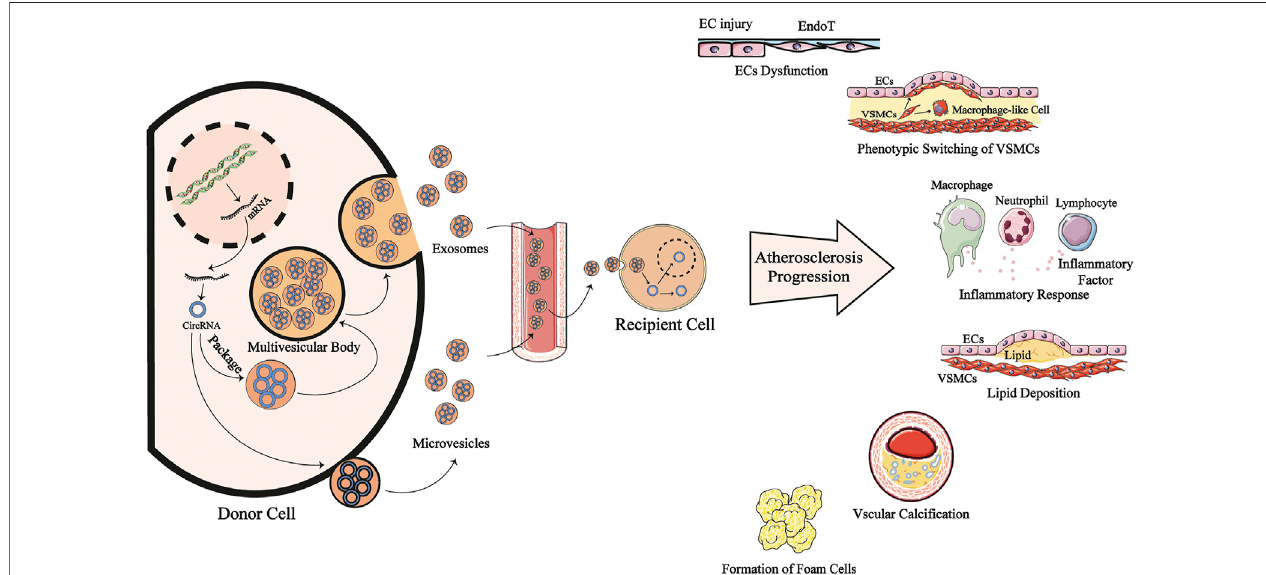
FIGURE2| EV-transmittedcircRNAsareinvolvedintheprogressionofAS.CircRNAsareproducedbyback-splicingfrommRNAandputintoextracellularvesicles mainly exosomes and microvesicles, becoming EV-circRNAs. This process may be interfered by risk factors of antheroslerosis. After entering systemic circulation, theses EV-circRNAs are transported to recipient cells and regulating cells function in cytoplasm or nucleus. They may modulate the dysfunction of endothelial cells, phenotype switching of VSMCs, in fl ammatory response, lipid deposition, vascular calci fi cation and the formation of form cells to participate in antherosclerosis pathogenesis. CircRNA: circular RNA; mRNA: messenger RNA; ECs: endotherlial cells; VSMCs: vascular smooth muscle cells; EndoT; Endothelial mesenchymal transition.